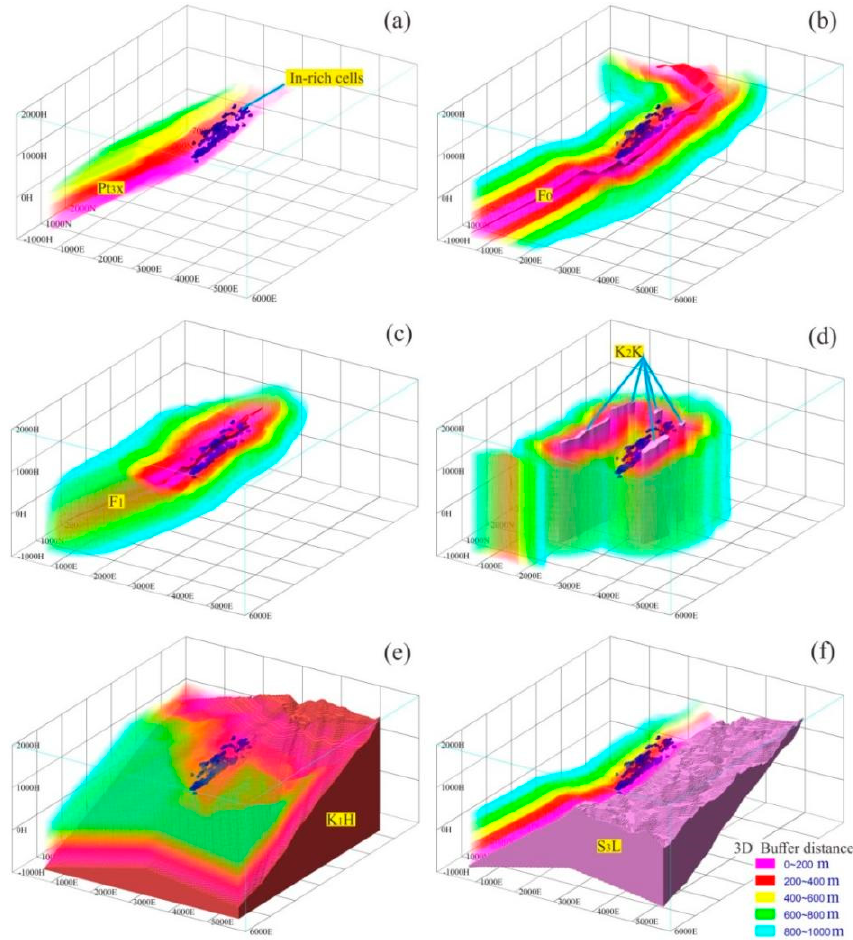
Figure 4. Ore-controlling geological factors and 3D buffer zone. ( a ) Buffer zone of Neoproterozoic Xinzhai Formation (Pt 3 x); ( b , c ) Buffer zone of faults (F 0 and F 1 ); ( d – f ) Buffer zone of granite porphyries and granites (K 2 K, K 1 H, and S 3 L).